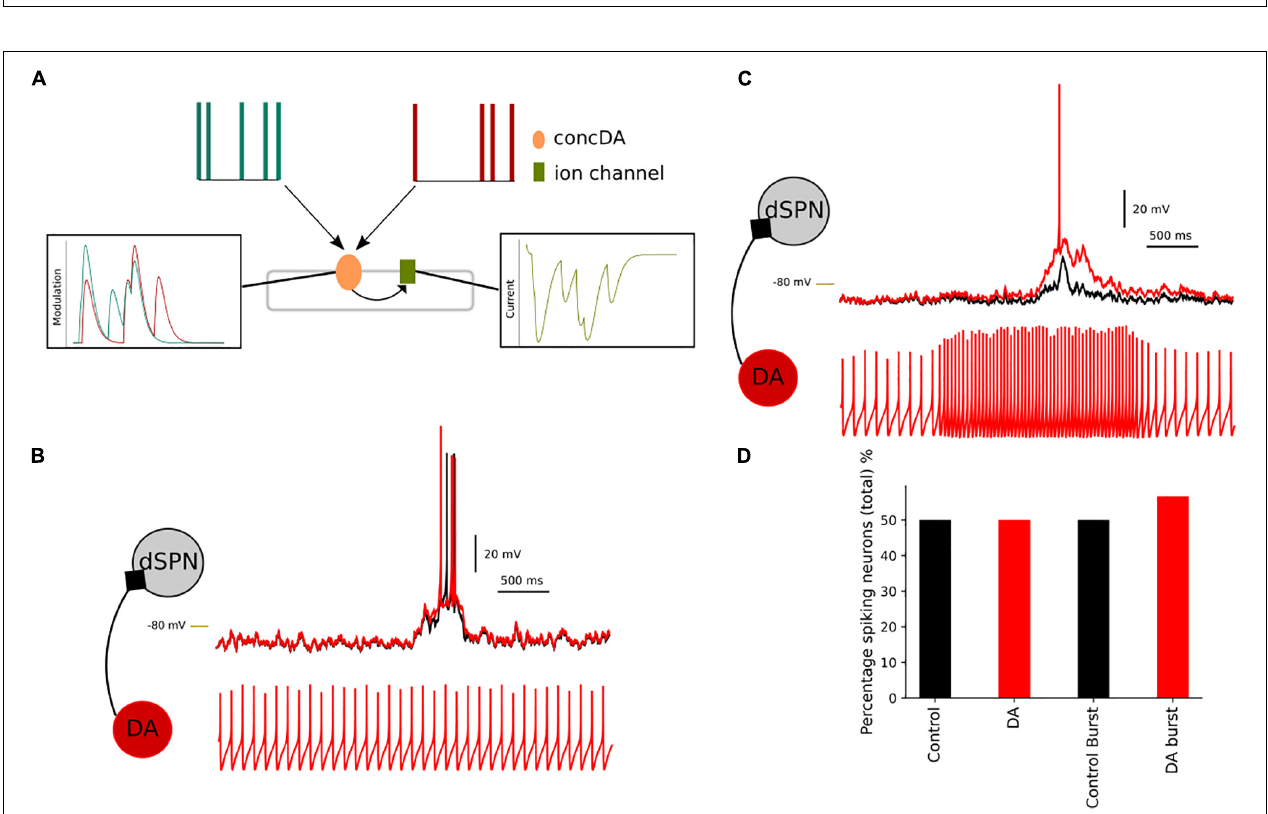
FIGURE 11 | Simulating presynaptic spiking neurons and dopaminergic neuromodulation. In (A) , a schematic representation of the adaptive mode, concDA (orange) placed on a segment within the multicompartmental model, which receive input from presynaptic cells (red and green). Every spike input triggers a transient inside the concDA which is sent to the ion channel (green) on that particular segment, rightmost panel in (A) hence modulating the current. In (B) , a simulation of a network of dSPNs, where neuromodulation depends on presynaptic spontaneously active neurons. Compared to control (without modulation) (black), the simulation with the presynaptic neurons produces a depolarization in dSPNs (red). If the frequency of the presynaptic neuron increases (C) , this translates to an increase in the neuromodulation. The dSPN depolarises more than in the spontaneous case and this results in an increase in the percentage of spiking neurons. In (D) , the bar chart shows the comparison between control and spontaneous versus bursting presynaptic cell (and control for bursting simulation, where the connections between the cells were disabled). The percentage of spiking cells within the network increases following the dopamine modulation which occurs when the presynaptic cell firing frequency increased. –80 mV marked by yellow